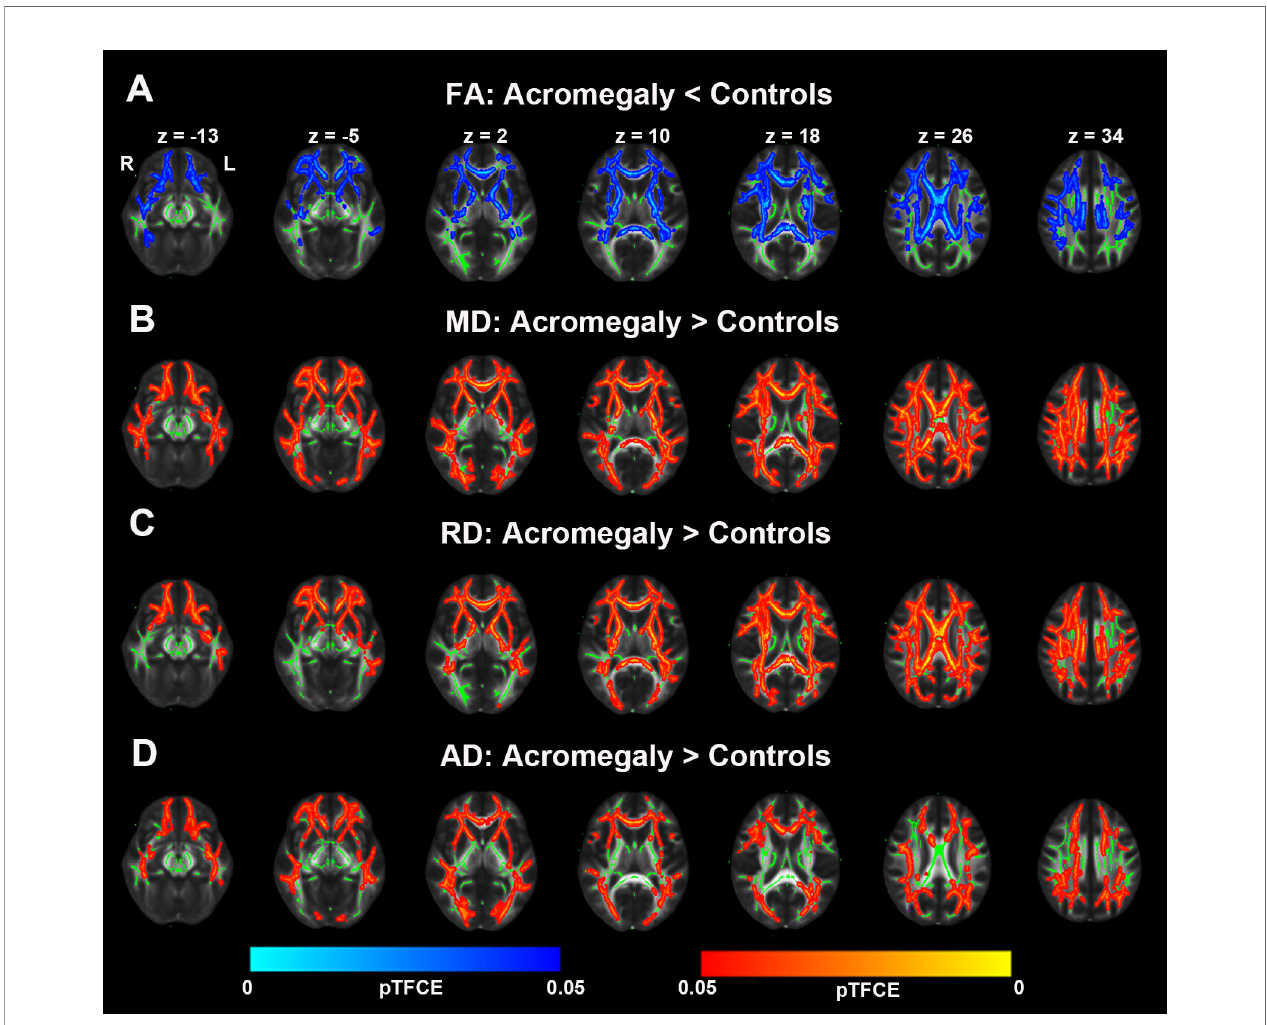
FIGURE 4 | Microstructural pathological alterations in DTI metrics in white matter in acromegaly. (A) Tract-based spatial statistics (TBSS) analysis of the DTI showed FA signi fi cantly decrease in widespread fi ber bundles in acromegaly compared with controls (Blue, pTFCE < 0.05). (B – D) MD, RD, and AD signi fi cantly increase in widespread fi ber bundles in acromegaly compared with controls (Red-yellow, pTFCE <